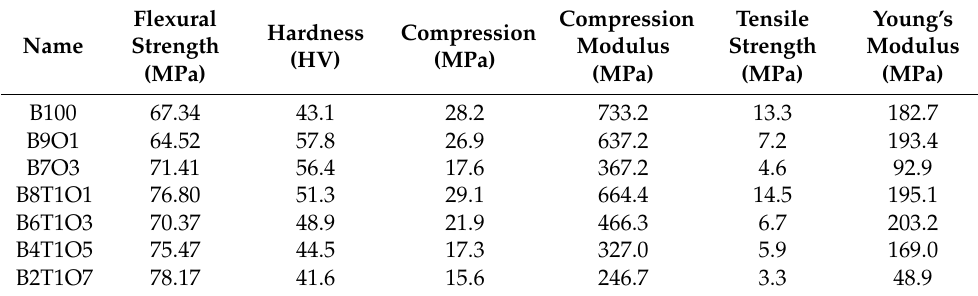
Table 3. Mechanical properties of urethane acrylate resin